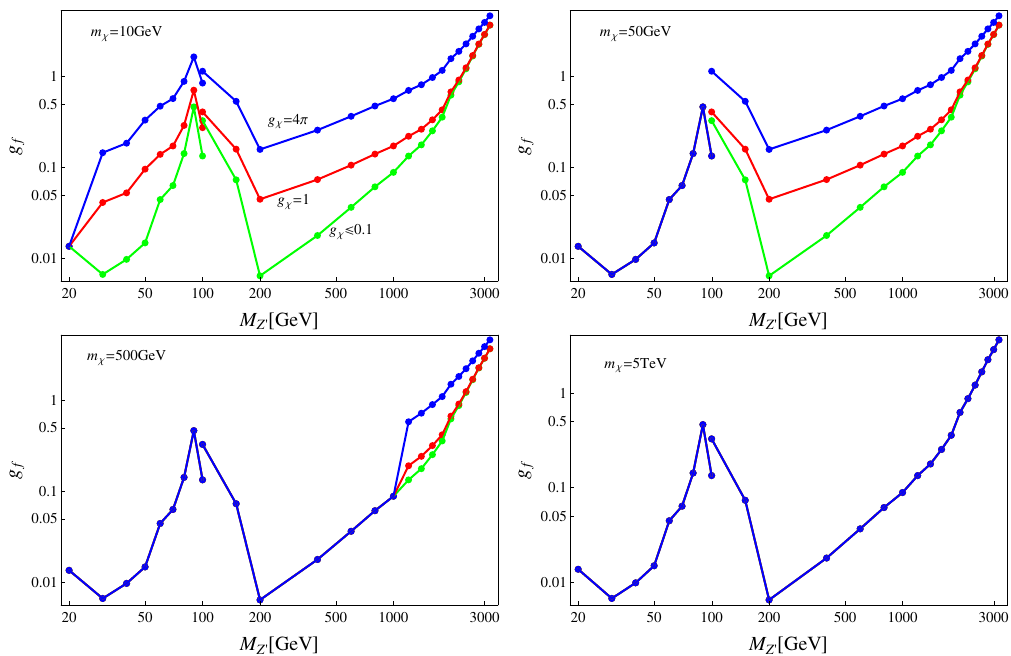
Figure 3 . The 95% CL exclusion regions from the searches for dimuon resonances at the 7 and 8 TeV LHC. Four di(cid:11)erent DM masses and three DM- Z 0 couplings were chosen to illustrate the collider bounds from those experiments. The constraints for the various g (cid:31) degenerate into a single bound in the region M Z 0 (cid:20) 2 m (cid:31) . The lines are discontinued at M Z 0 = 100 GeV, the point we chose to switch from the CMS 7 TeV data [65] to the ATLAS 8 TeV data